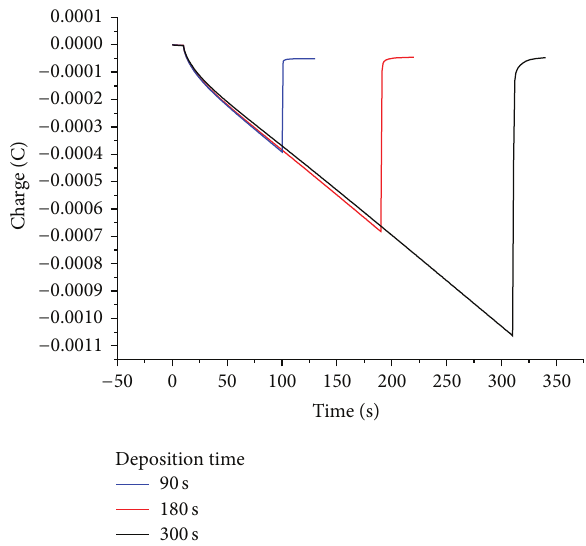
Figure 11: Chronocoulometry plot of thallium deposition with varying time and removal ] n glassy carbon electrode in the presence of 1mM TlSO 4 in deaerated 0.5 M H 2 SO 4 solution.